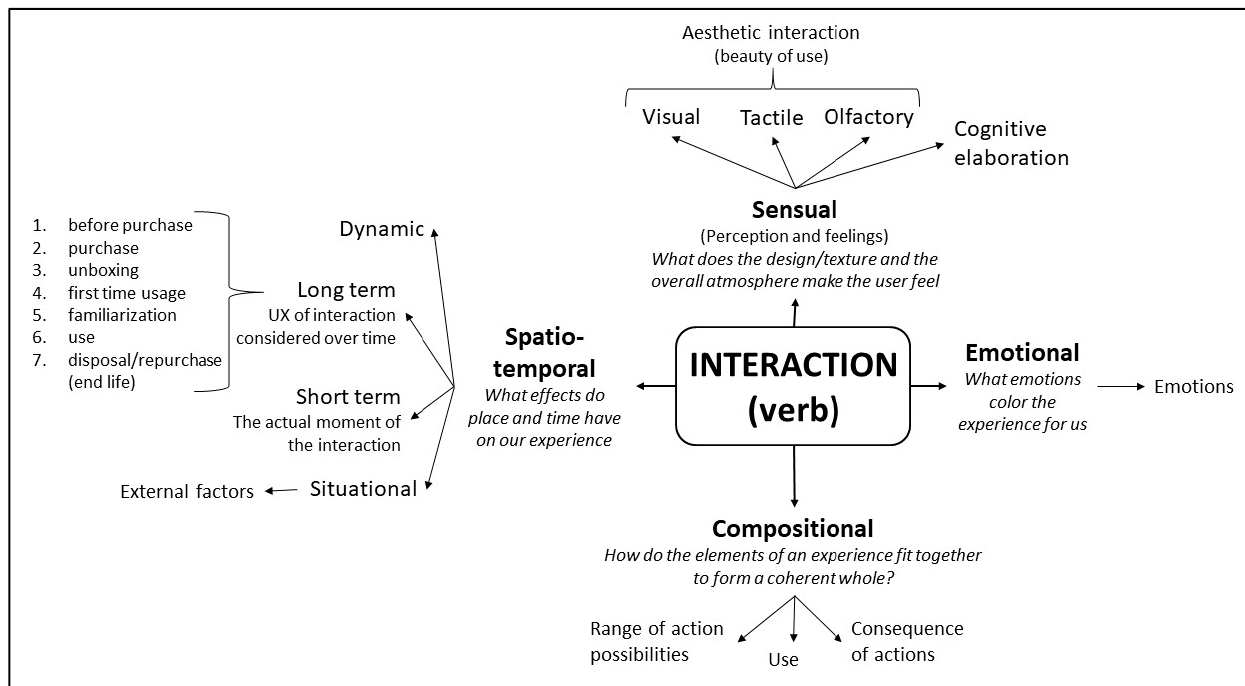
Figure 3. Scheme based on the four intertwined threads individuated by (McCarthy and Wright, 2004) and enriched with other scholars’ interpretations.